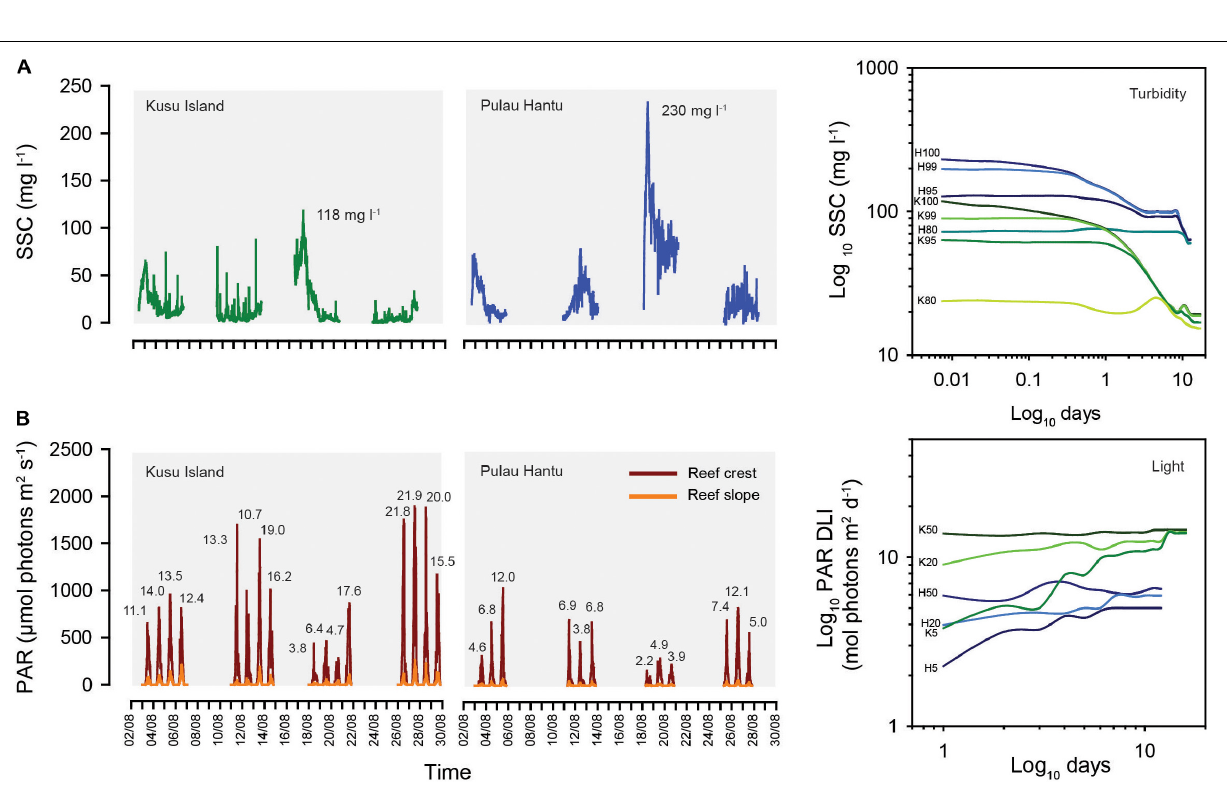
derived from running means across the full range of time- scales were 2-fold lower at Kusu (11.5–15.6 mg l − 1 ) than at Hantu (40–42.5 mg l − 1 ). Collectively, running means percentile analysis shows pronounced separation in turbidity regimes between the reefs.